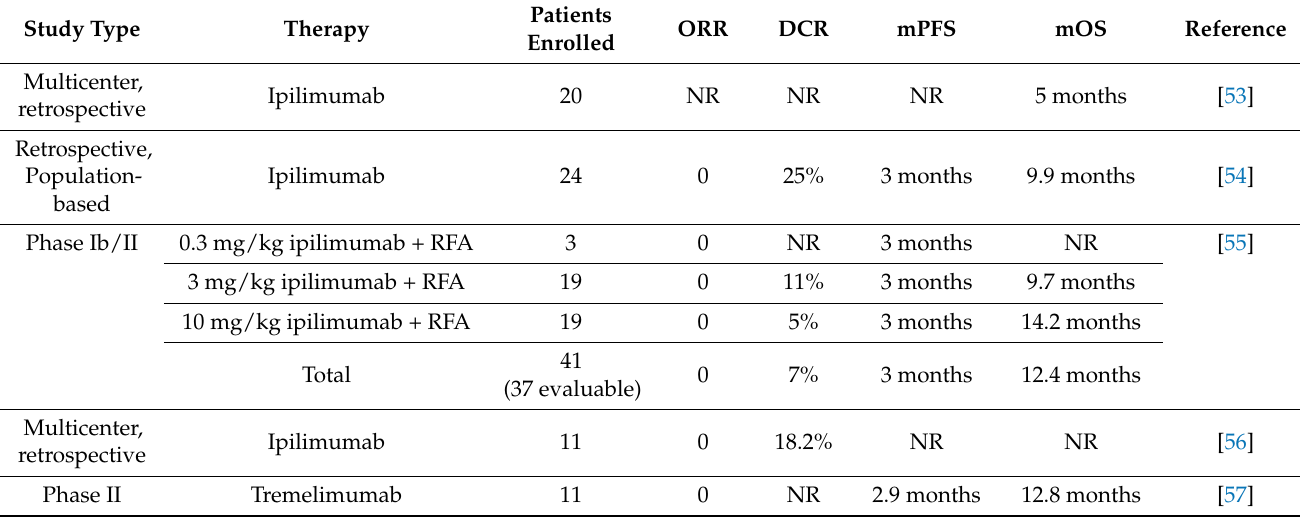
Table 1. Clinical studies with CTLA-4 inhibitors in metastatic UM